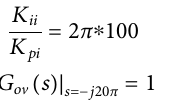
Frontiers in Energy Research |